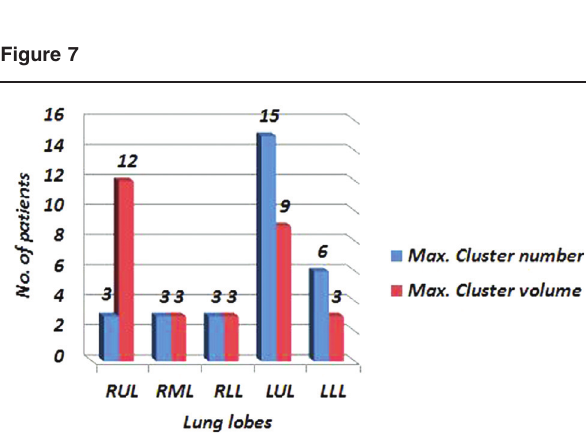
The pulmonary distribution of the maximum cluster number and the maximum cluster volume. LLL, left lower lobe; LUL, left upper lobe; RLL, eight lower lobe; RML, right middle lode; RUL, right upper lobe.